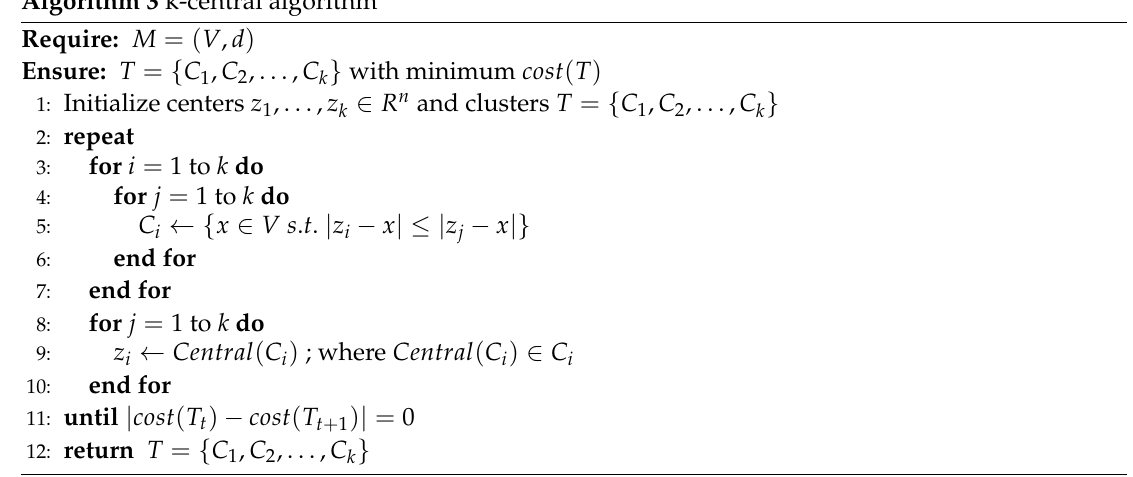
Algorithm 3 k-central